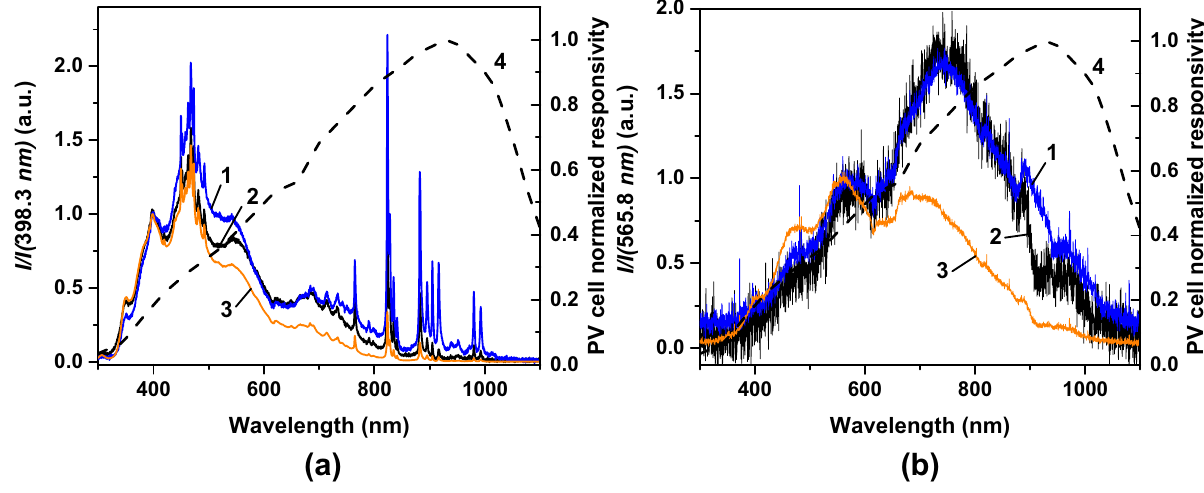
Figure 13: Normalized spectra of the photoluminescence at the edges of the LSC simulator. ( a ) LSC was illuminated with the solar simulator; ( b ) with the light bulb. Spectra 1 correspond to empty LSC ( true spectra of the light sources ) , 2 – LSC fi lled with pure 1 - propanol, 3 – LSC fi lled with the NaY - propanol, 4 – normalized responsivity of the PV cells. In ( a ) the spectra were nor - 0.83 F 4 :Yb 0.14 Er 0.03 nanocolloid in 1 malized to the intensity of the peak at 398.3 nm. In ( b ) the spectra were normalized to the intensity of the peak at 565.8